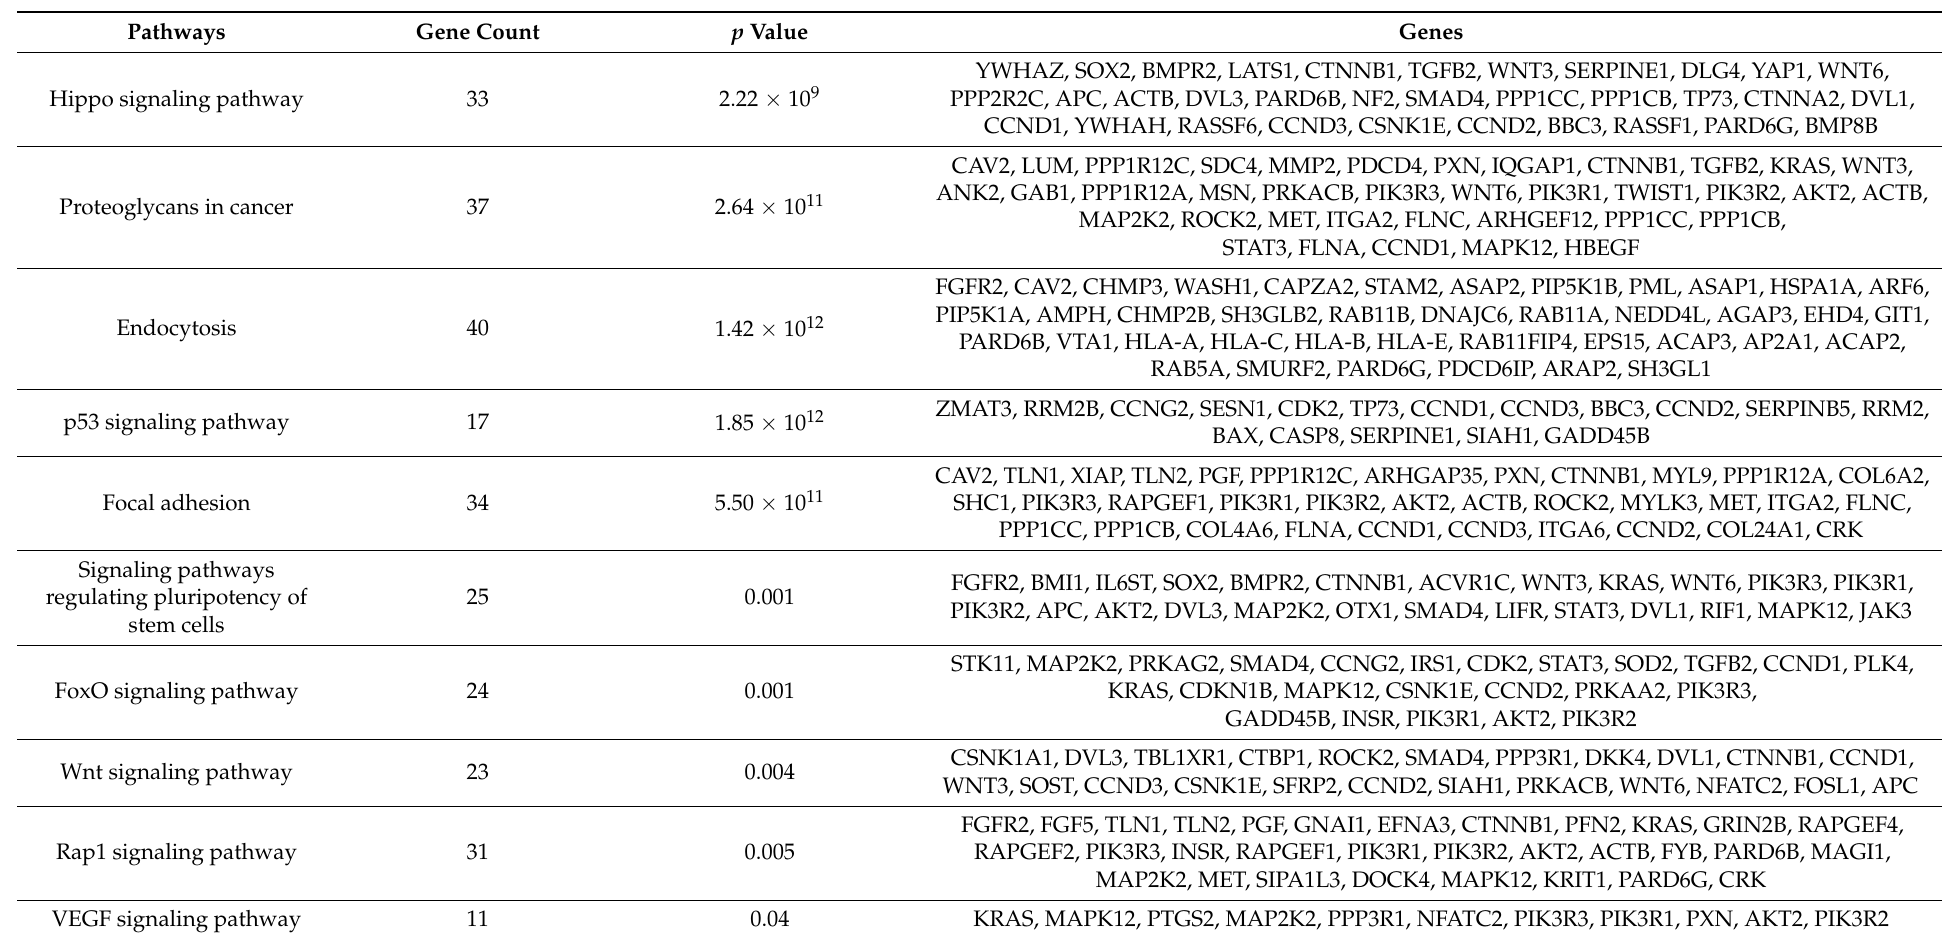
Table 4. Top 10 statistically relevant pathways derived from the common 2027-gene signature of U87 glioblastoma cells exposed to 2 and 10 Gy of proton irradiation under hypoxia